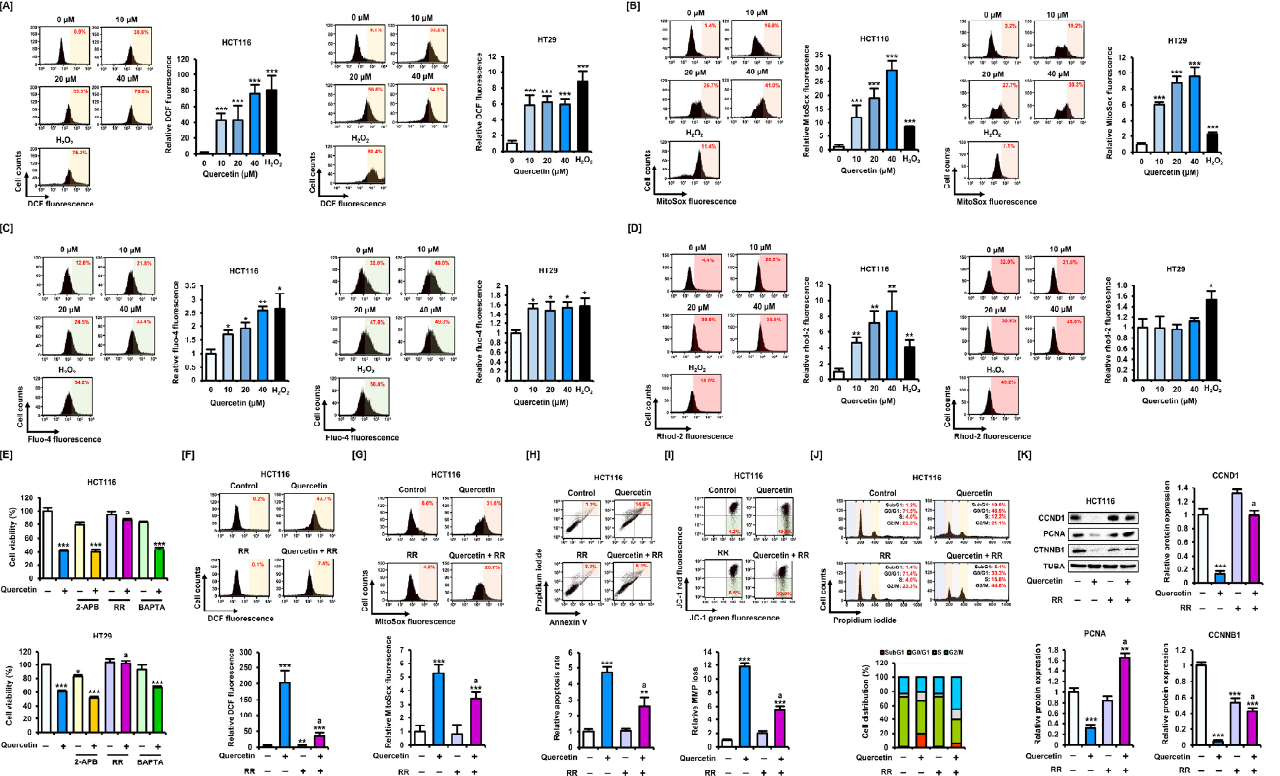
Figure 5. Quercetin causes oxidative stress and an increase in Ca 2+ in CRC cells. ( A ) Effects of quercetin on ROS production in HCT116 and HT29 cells over 1 h. Flow cytometry was used to estimate 2 (cid:48) ,7 (cid:48) -dichlorofluorescein (DCF) fluorescence values. ( B ) Effects of quercetin on